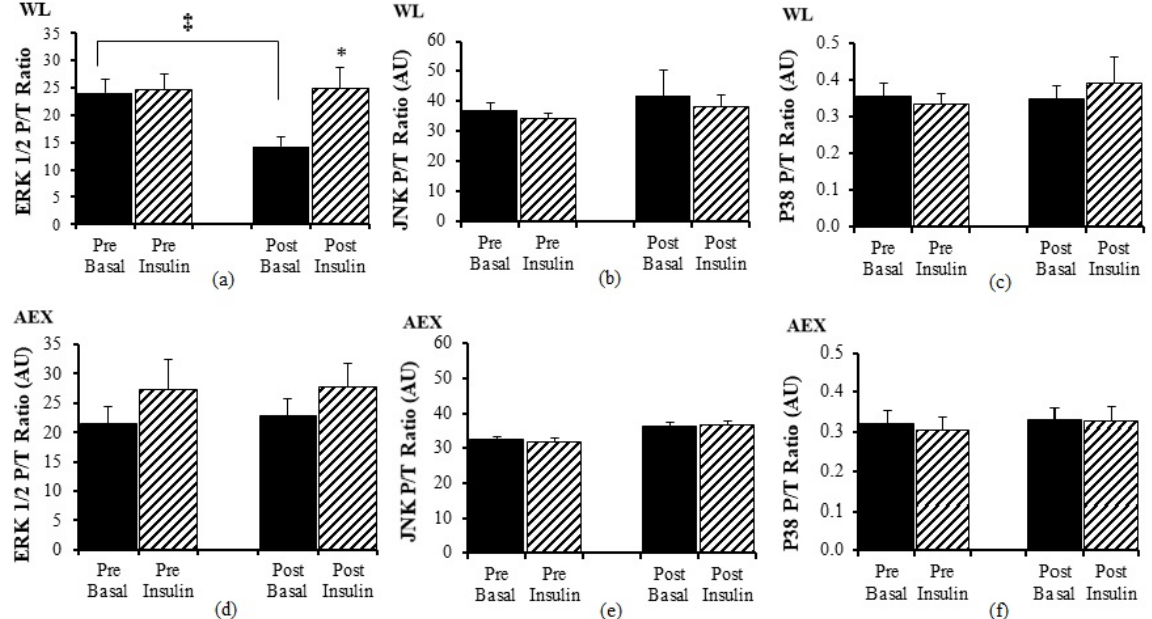
Figure 3. Skeletal muscle ERK1/2, JNK and p38 phosphorylation, and total protein expression ratio during basal (solid) and insulin-stimulated (striped) pre and post WL ( a – c ) and AEX ( d – f ). Paired t -tests between pre basal vs. pre insulin, post basal vs. post insulin, and pre vs. post basal analyses within WL and within AEX were performed using the SPSS software version 27 (SPSS Inc., Chicago, IL, USA). * p ≤ 0.05; ‡ p ≤